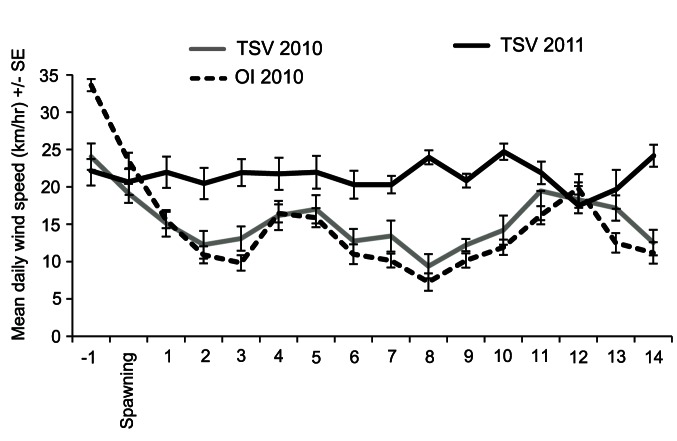
Wind speeds (daily averages of hourly readings ± S.E.) in the first 14 days post-spawning in 2010 and 2011.TSV = Bureau of Meteorology Townsville AERO Weather Station (BOM: 032040): OI = Great Barrier Reef Ocean Observing System Weather Station at Pioneer Bay, Orpheus Island GBROOS: RP3).